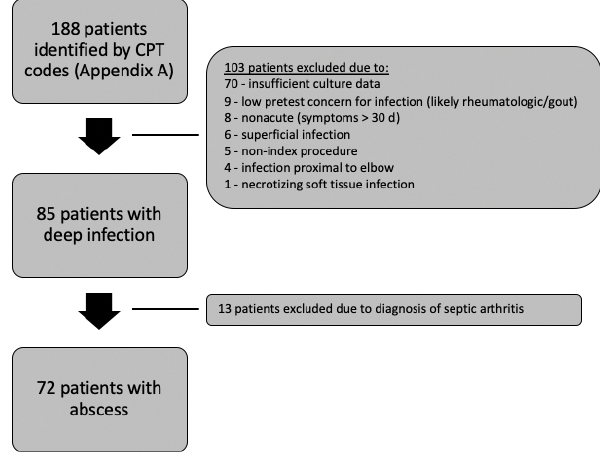
Figure 1. Exclusion criteria applied to obtain the final study cohort.